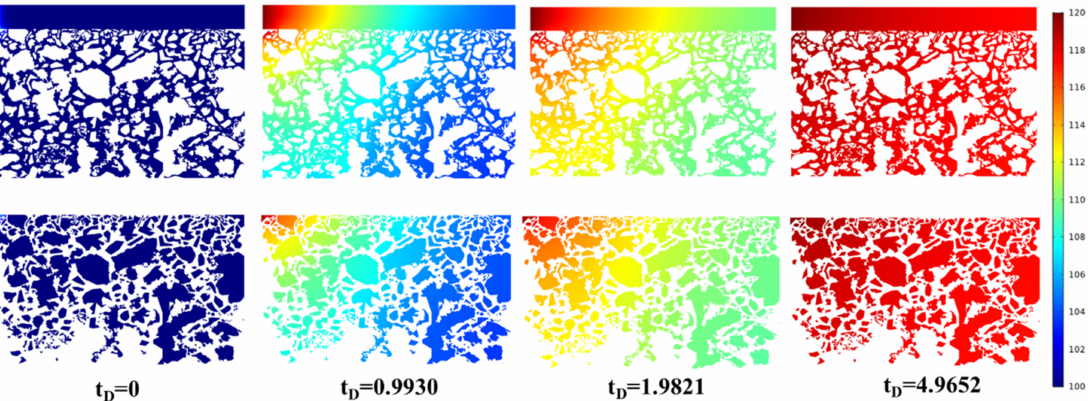
Figure 24. Temperature distribution at different times with T inj = 120 ◦ C.